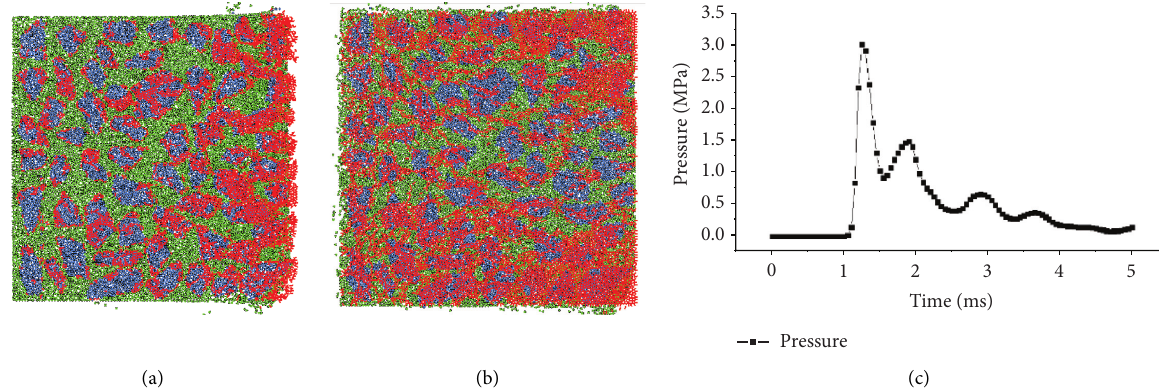
Figure 22: (a) The damage of point E4 at normal temperature, (b) the damage of point E4 at 700K, and (c) the compressive